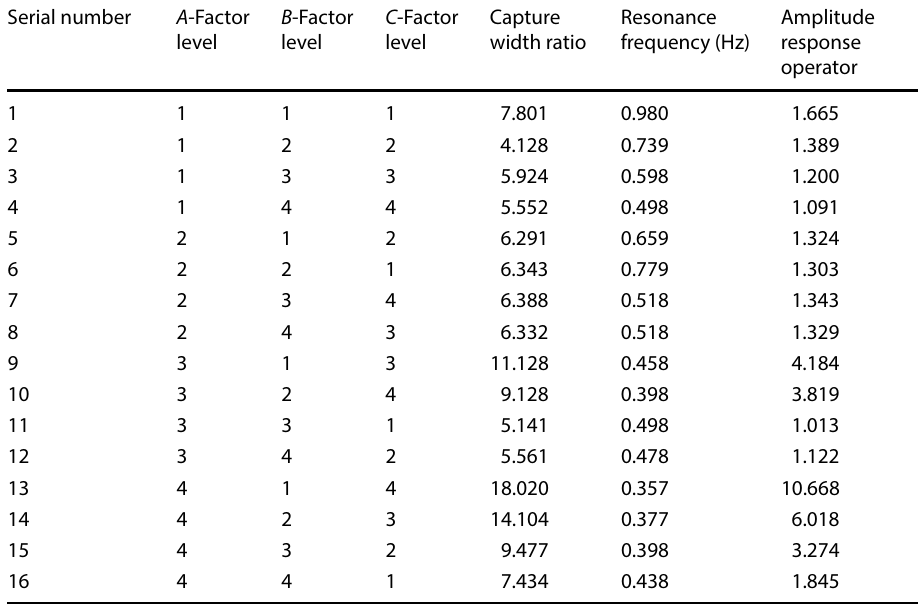
Table 2 Horizontal orthogonal table of experimental results